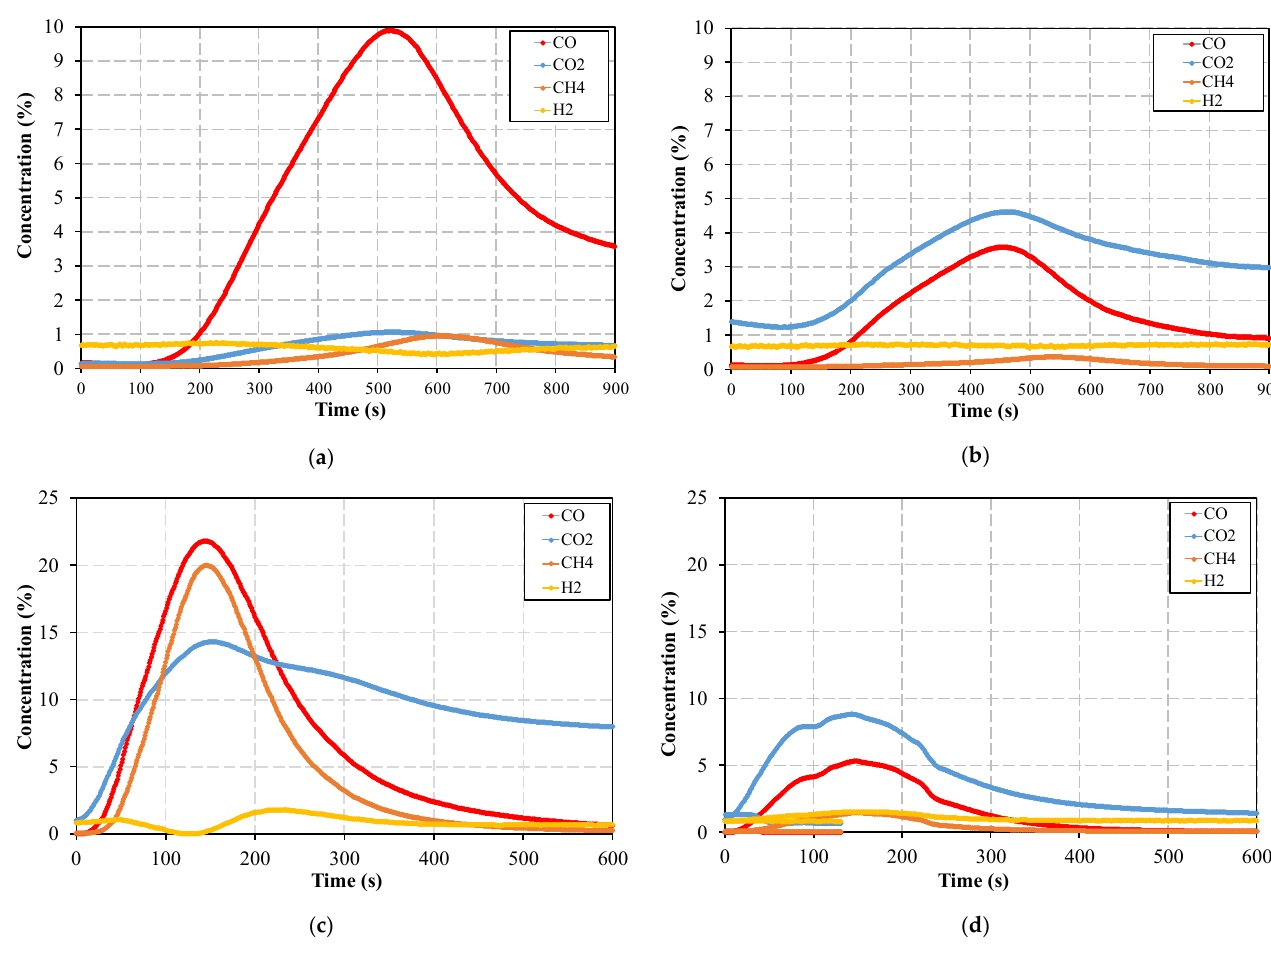
Figure 3. Gas emissions at different reactor temperatures and conversion conditions: ( a ) gasification at 400 °C, ( b ) combustion at 400 °C, ( c ) gasification at 800 °C, ( d ) combustion at 800 °C. at 400 ◦ C, ( b ) combustion at 400 ◦ C, ( c ) gasification at 800 ◦ C, ( d ) combustion at 800 ◦